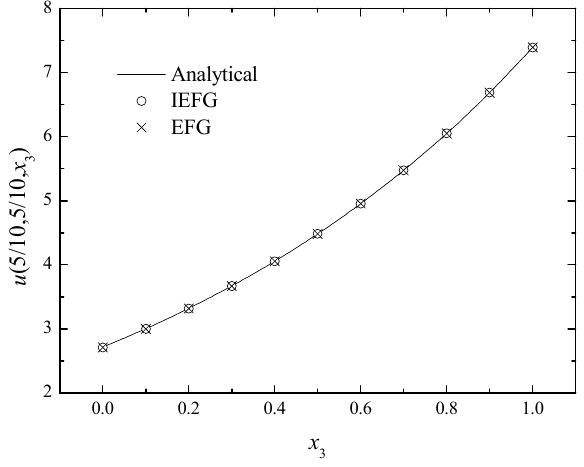
Figure 10. The comparison of numerical and exact solutions along x 3 -axis.